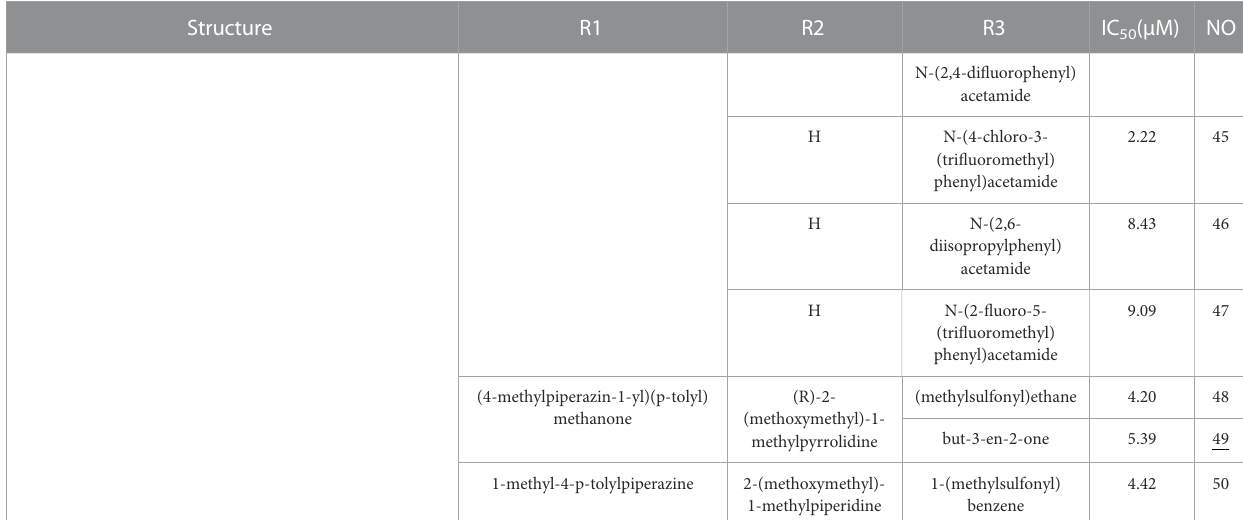
TABLE 1 ( Continued ) VEGFR3 kinase inhibition and activity values of compounds 1-